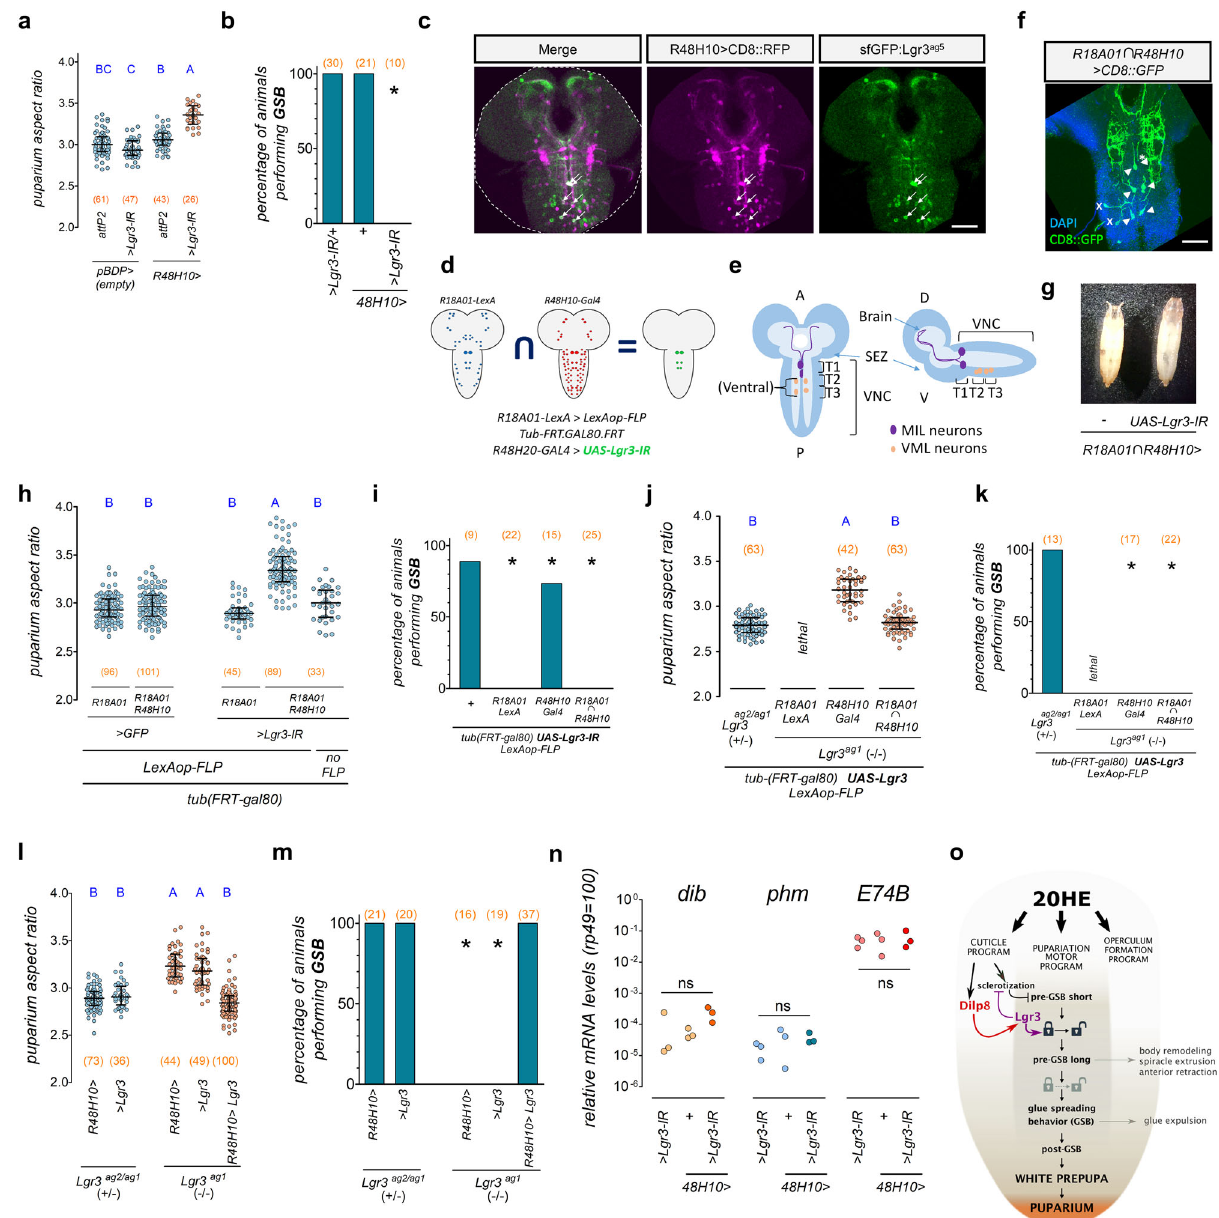
Fig. 7 Lgr3 is required in six thoracic interneurons for PMP progression. a Lgr3 knockdown in R48H10 > neurons increases puparium aspect ratio (AR). Shown are dot plots of puparium AR. b Lgr3 knockdown in R48H10 > neurons impedes GSB. Shown is the percentage of animals of the depicted genotypes that perform GSB. > Lgr3-IR/ + data, same as Fig. 5f. c Six thoracic (6VNC) interneurons (white arrows) co-express R48H10 > CD8::RFP (magenta) and sfGFP::Lgr3 ag5 (anti-GFP, green). d R18A01 ∩ R48H10 intersectional genetics system. e Cartoon of the 6VNC R18A01 ∩ R48H10 neurons. SEZ, subesophageal zone. T1-3, thoracic segments. f 6VNC neurons (arrowheads) express R18A01 ∩ R48H10 > CD8::GFP (green). DAPI, blue. Asterisk, non-visible MIL neuron. X, non-reproducible cells. g Photos of control and R18A01 ∩ R48H10 > Lgr3-IR puparia. h R18A01 ∩ R48H10 > Lgr3-IR increases puparium AR. Shown are dot plots of puparium AR. Quanti fi cation of ( g ). i R18A01 ∩ R48H10 > Lgr3-IR abrogates GSB. R18A01-LexA ( R18A01» ) alone abrogates GSB. Shown is the percentage of animals of the depicted genotypes that perform GSB. j Lgr3 expression ( UAS-Lgr3 ) in R18A01 ∩ R48H10 neurons rescues puparium AR in Lgr3 mutants. Shown are dot plots of puparium AR. k Lgr3 expression in R18A01 ∩ R48H10 neurons does not rescue GSB. Shown is the percentage of animals of the depicted genotypes that perform GSB. l Lgr3 expression in R48H10 neurons rescues puparium AR in Lgr3 mutants. Shown are dot plots of puparium AR. m Lgr3 expression in R48H10 neurons rescues GSB in Lgr3 mutants. Shown is the percentage of animals of the depicted genotypes that perform GSB. n R48H10 > Lgr3-IR does not alter phm, dib , or E74B mRNA levels in WPP T0 animals. Dot plots showing qRT-PCR estimations of the depicted genes. o Model: Dilp8-Lgr3 pathway promotes pupariation program progression. Statistics (full details in Supplementary Table 2): a , h , j , l Dots: one animal. Horizontal bar, median. Error bars, 25-75%. n Dots: biological repeats. a , h , j , l , n ANOVA, followed by a Holm-Sidak ’ s test. h , j , l Dunn ’ s test. n ns not-signi fi cant. b , I , k , m Binomial tests with Bonferroni correction. Same blue letters, corrected P > 0.05. (N) Number of animals (orange). Scale bars, 50 µ